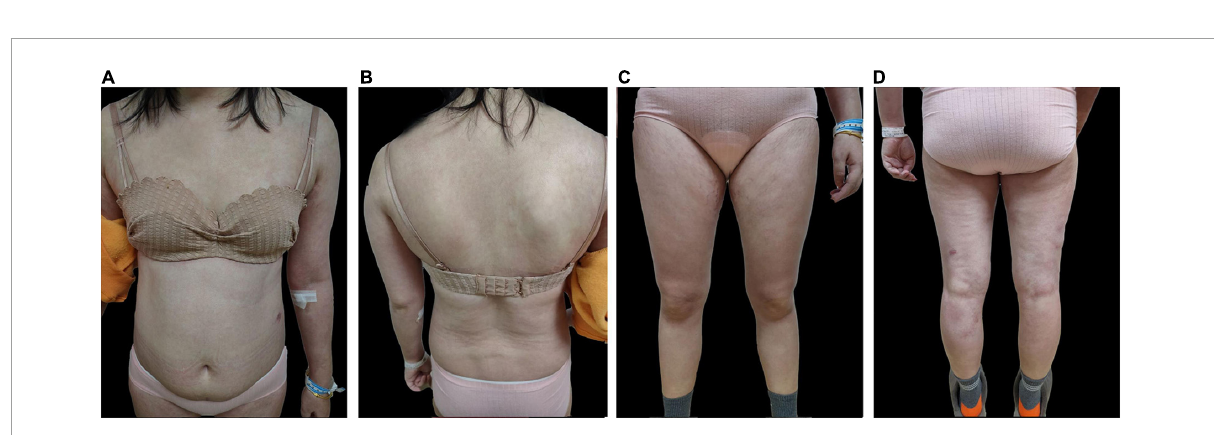
FIGURE3 Post-treatment skin images of (A) anterior skin lesions (B) posterior skin lesions (C) anterior lower extremities (D) posterior lower